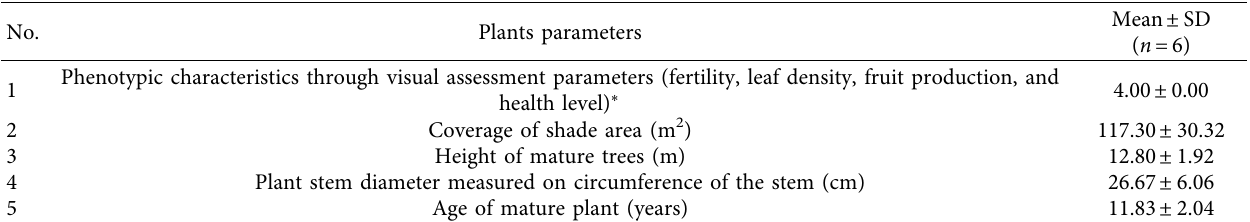
Table 1: Phenotypic characteristics of selected Styrax benzoin (Sumatra benzoin) trees used in the isolation of cinnamic acid.